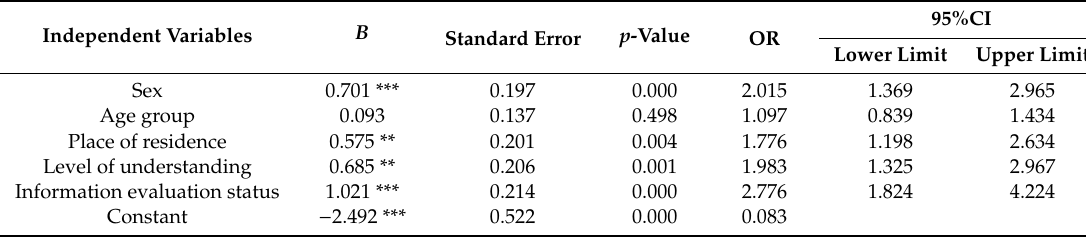
Table 10. Logistic multivariate regression analysis of COVID-19 protective behaviors based on di ff erent population